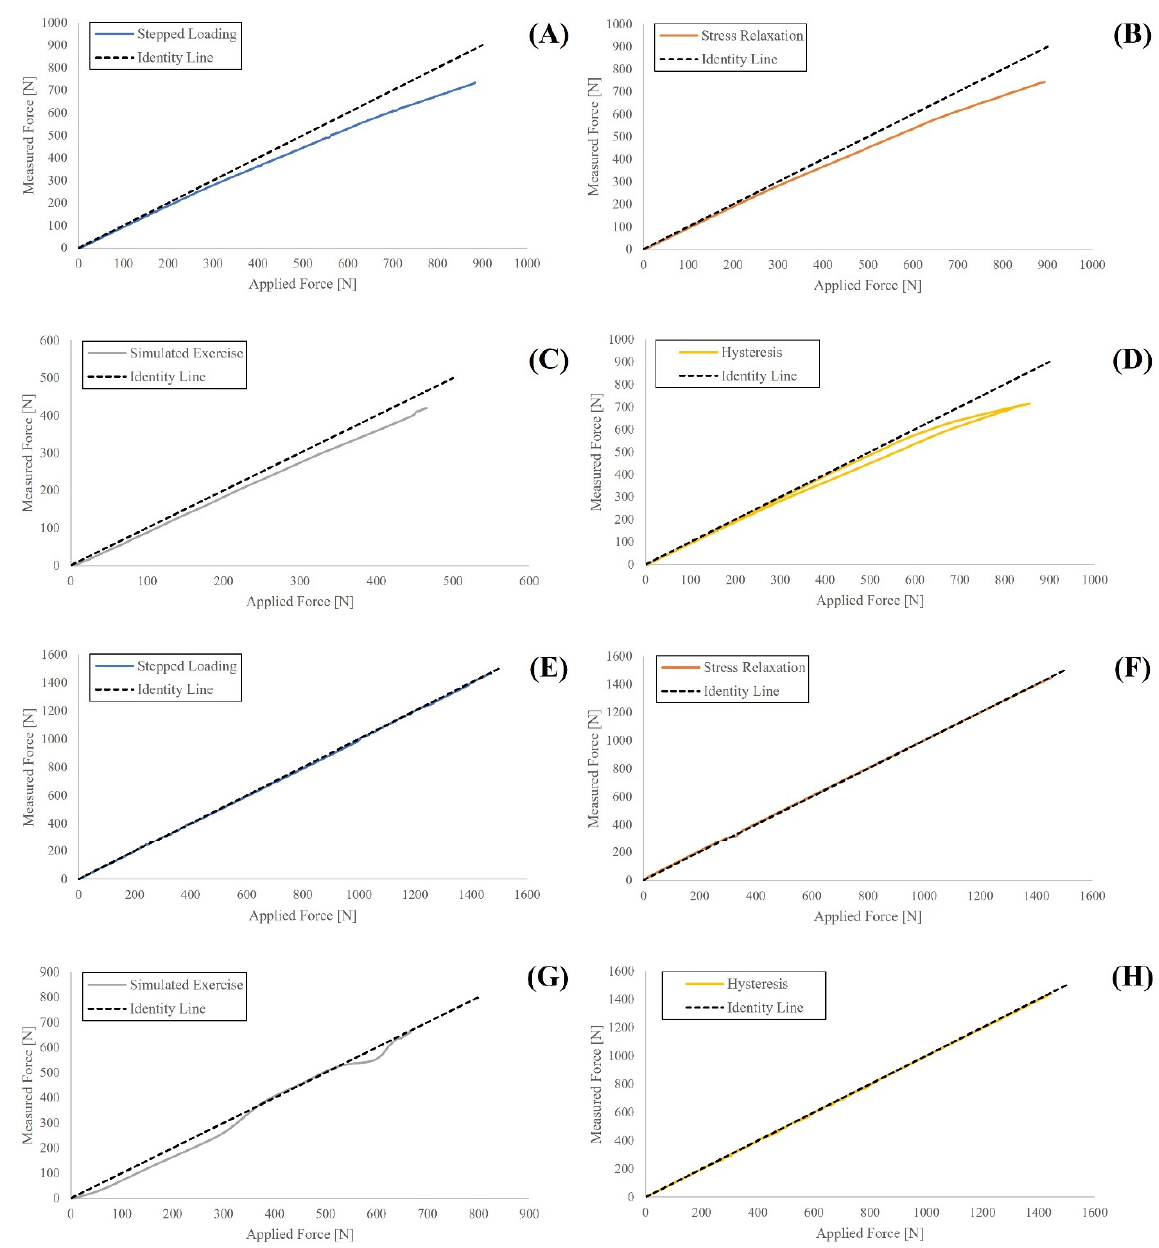
Figure 3. Mean force values across three testing repetitions of each test type comparing the force applied by the gold standard (Instron) against the force measured by the ActivBody Activ5 for ( A ) Stepped Load Test; ( B ) Stress Relaxation Test; ( C ) Simulated Exercise Test; and ( D ) Hysteresis Test. Additionally, force applied by the gold standard (Instron) against the force measured by the Tindeq Progressor for ( E ) Stepped Load Test; ( F ) Stress Relaxation Test; ( G ) Simulated Exercise Test; and ( H ) Hysteresis Test. The identity line indicating a perfect linear relationship is also shown.